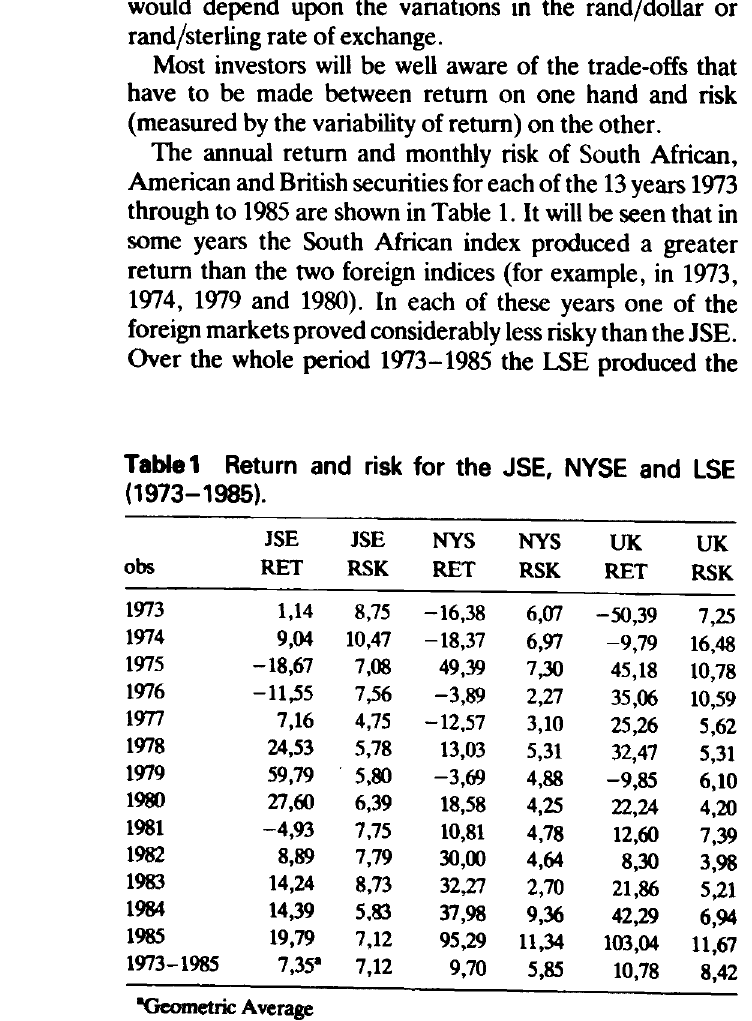
Return and risk for the JSE, NYSE and LSE